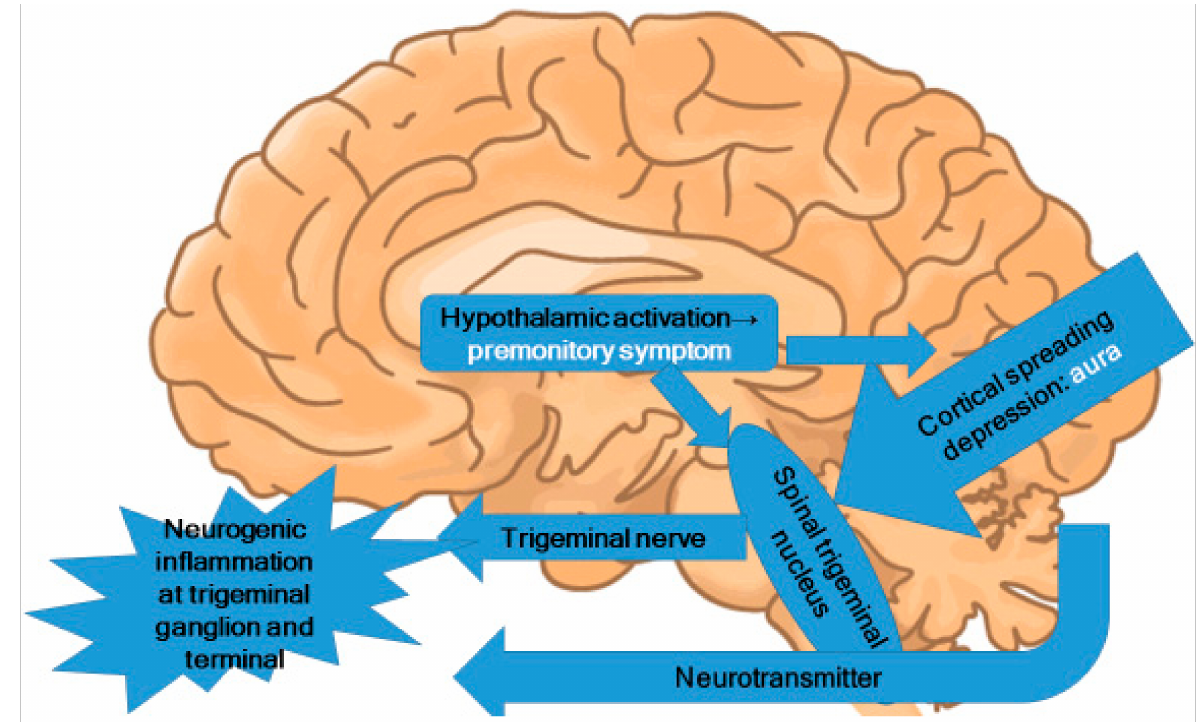
Figure 2. Central pathophysiology of